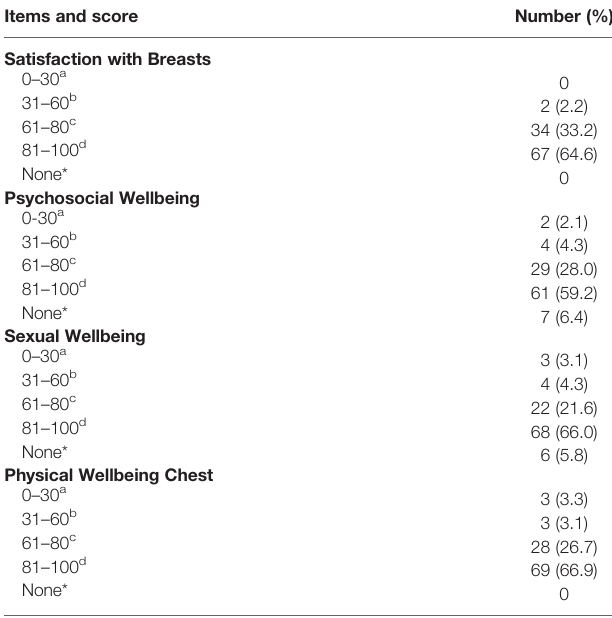
TABLE 4 | BREAST-Q reconstruction module